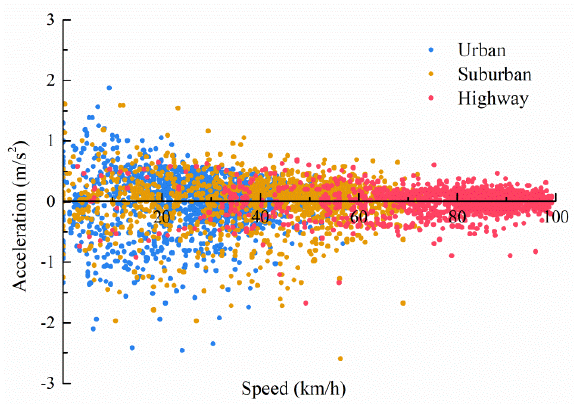
Figure 3. The speed-acceleration distribution during the test of LDDT3 (China Ⅴ